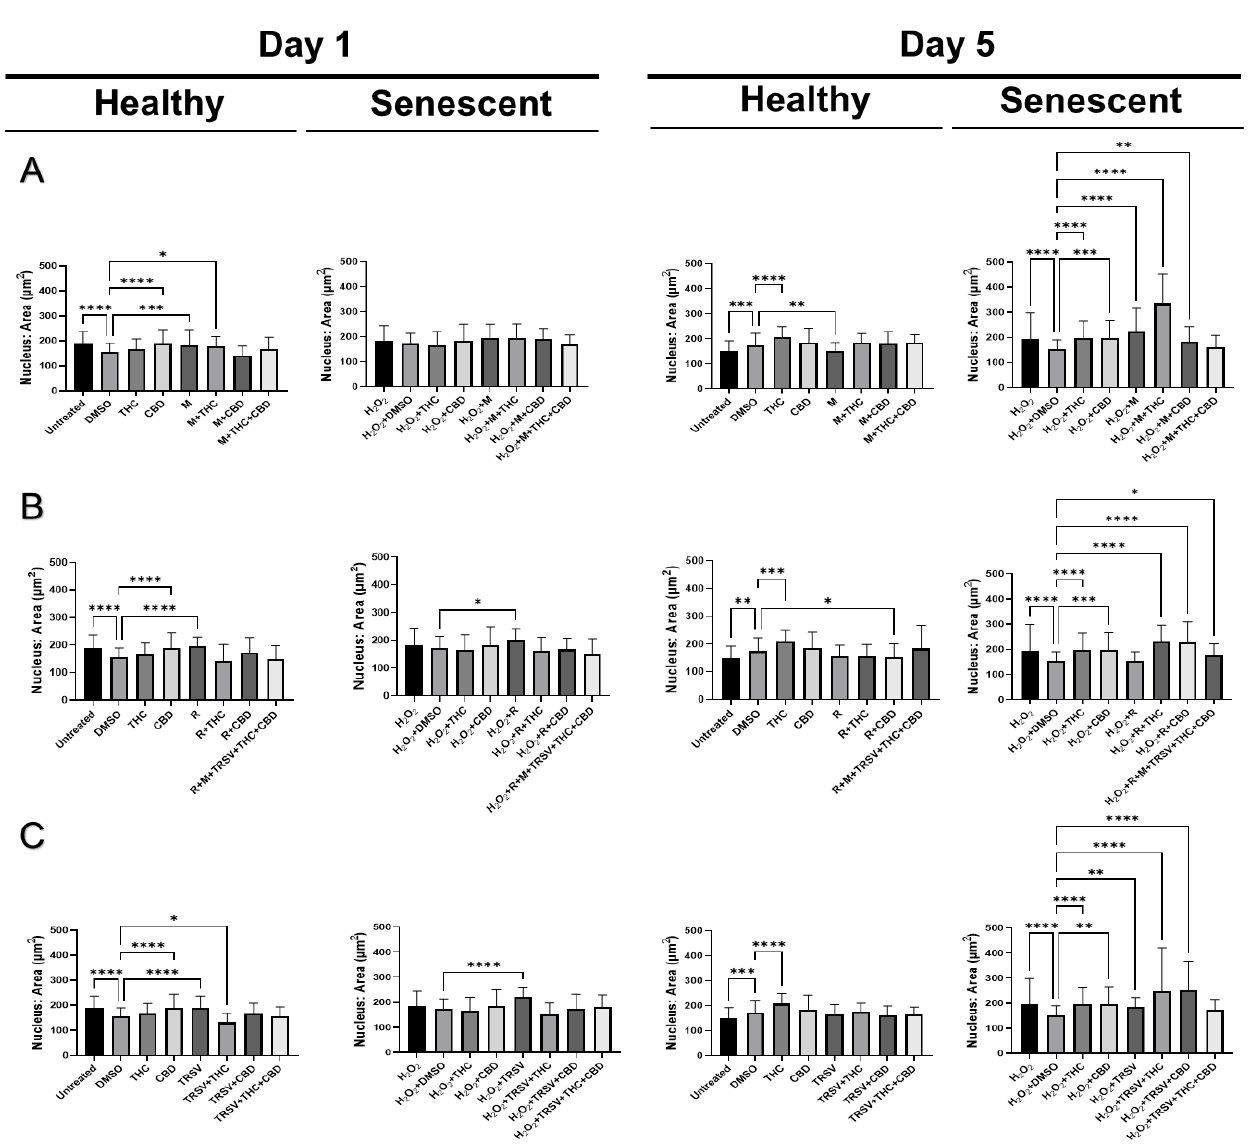
Figure 8. DAPI-stained nuclei area parameters of skin fibroblasts CCD-1064Sk (p.11) exposed to metformin, triacetylresveratrol, and rapamycin combined with pCBs. Nuclear parameters were observed by immunofluorescence microscopy for healthy and senescent fibroblasts treated with ( A ) 500 µ M metformin, ( B ) 5 µ M rapamycin, or ( C ) 10 µ M triacetylresveratrol and combinations with pCBs compared to 2 µ M of THC, 2 µ M of CBD, DMSO, and untreated fibroblasts after 1 day and 5 days of exposure. Data were analyzed with a one-way ANOVA test followed by a Dunnett’s post hoc test compared to the DMSO or H 2 O 2 + DMSO control. Bars represent mean ± SD. Significance is indicated within the figures using the following scale: * p < 0.05, ** p < 0.01, *** p < 0.001, **** p < 0.0001. CBD, cannabidiol; DMSO, dimethyl sulfoxide (vehicle), M, metformin; R, rapamycin; THC, Δ -9-tetrahydrocannabinol; TRSV, triacetylresveratrol.